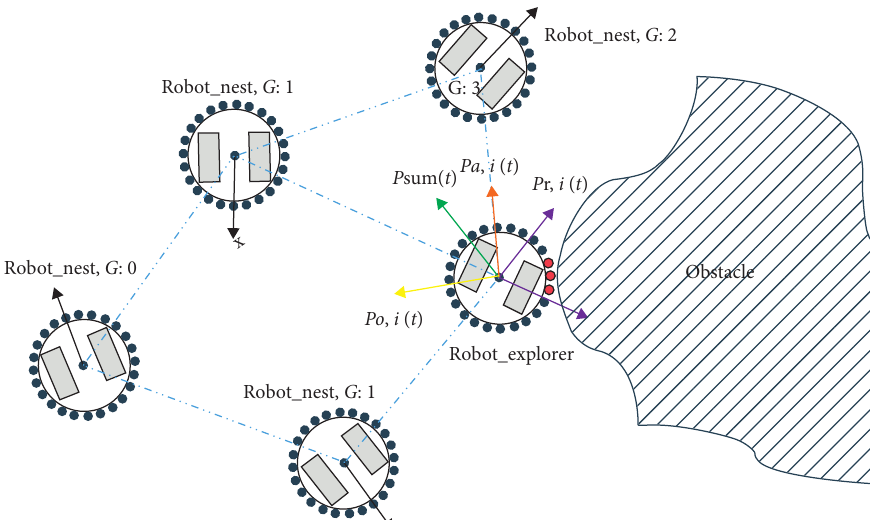
Figure 7: Example of the motion mechanism. The dash-dotted lines represent the interrobot communication network. The purple arrows → ( t ) represent the repulsive forces of Robot_Nodes with a gradient value of 1 on Robot_Explorer i in the t th time step. The red arrow P → r,i ( t ) represents the attractive force of a Robot_Node with a gradient value of 2. P P a,i sum of all the above